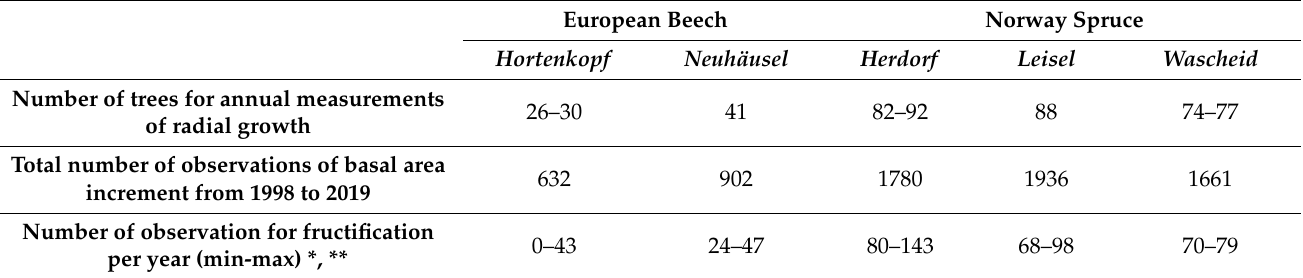
Table 2. Extent of the dataset from